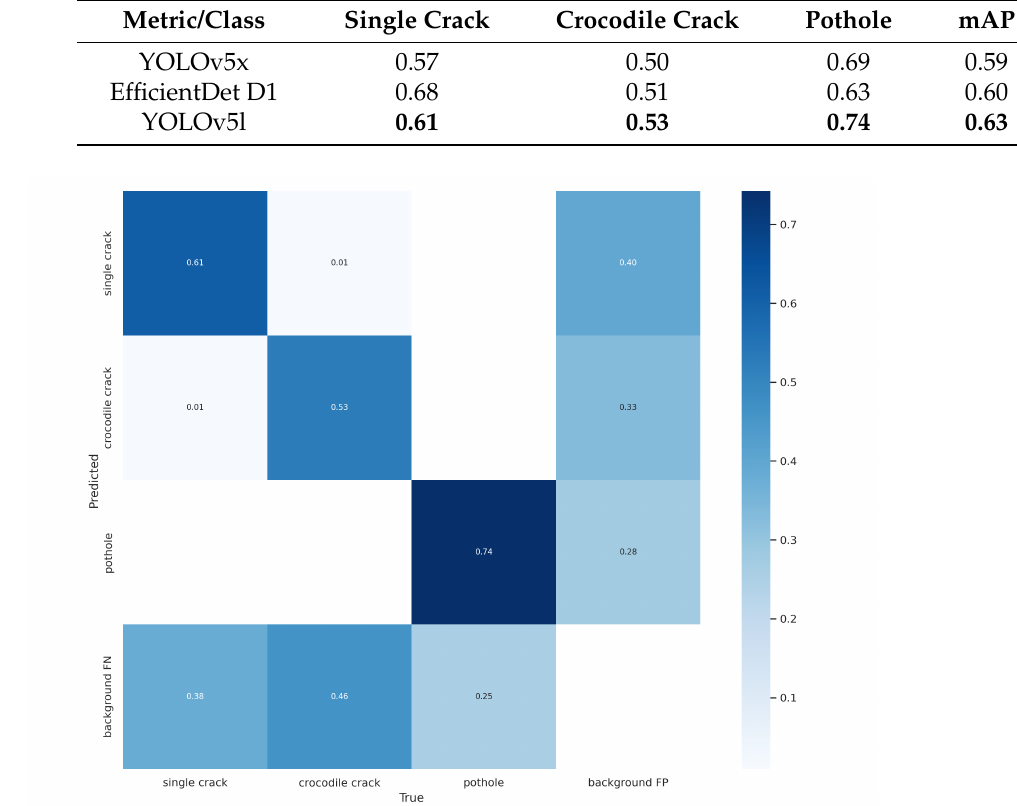
Figure 8. Confusion matrix on the test subset of the augmented dataset running YOLOv5l.